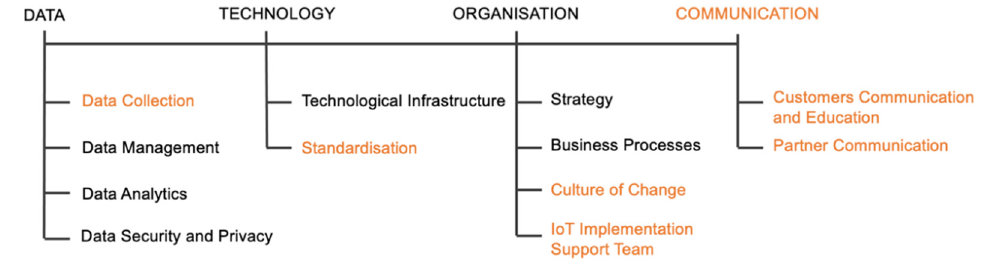
Figure 2. Final maturity model.